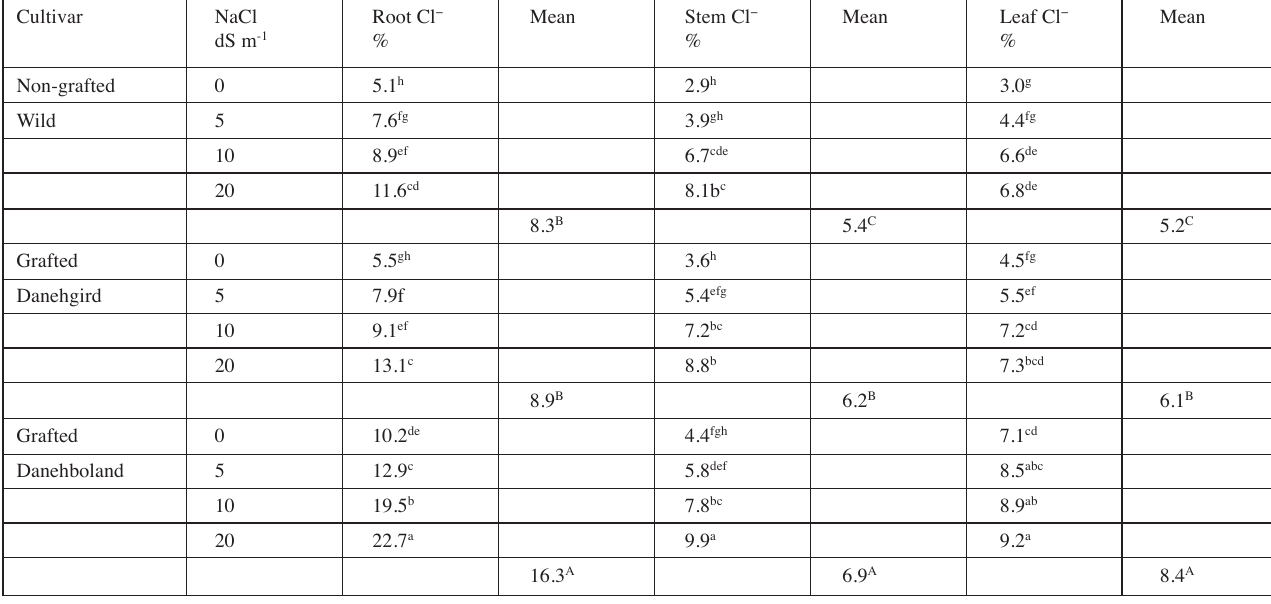
Tab. 7: Sodium chloride effect on leaf, stem and root Cl − (%) of non-grafted wild, grafted ‘Danehgird’ and ‘Danehboland’ cultivars of Z. spina-christi .